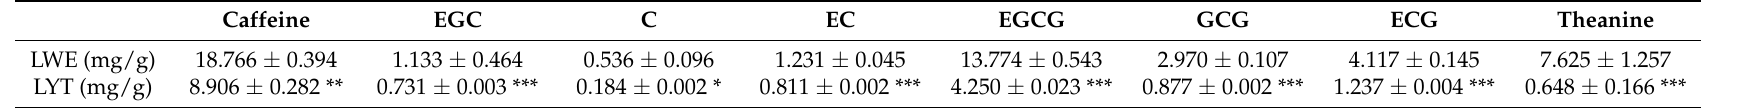
Table 1. Quantitative data for catechins, caffeine, and theanine in large yellow tea (LYT) and its water extract (LWE) via HPLC